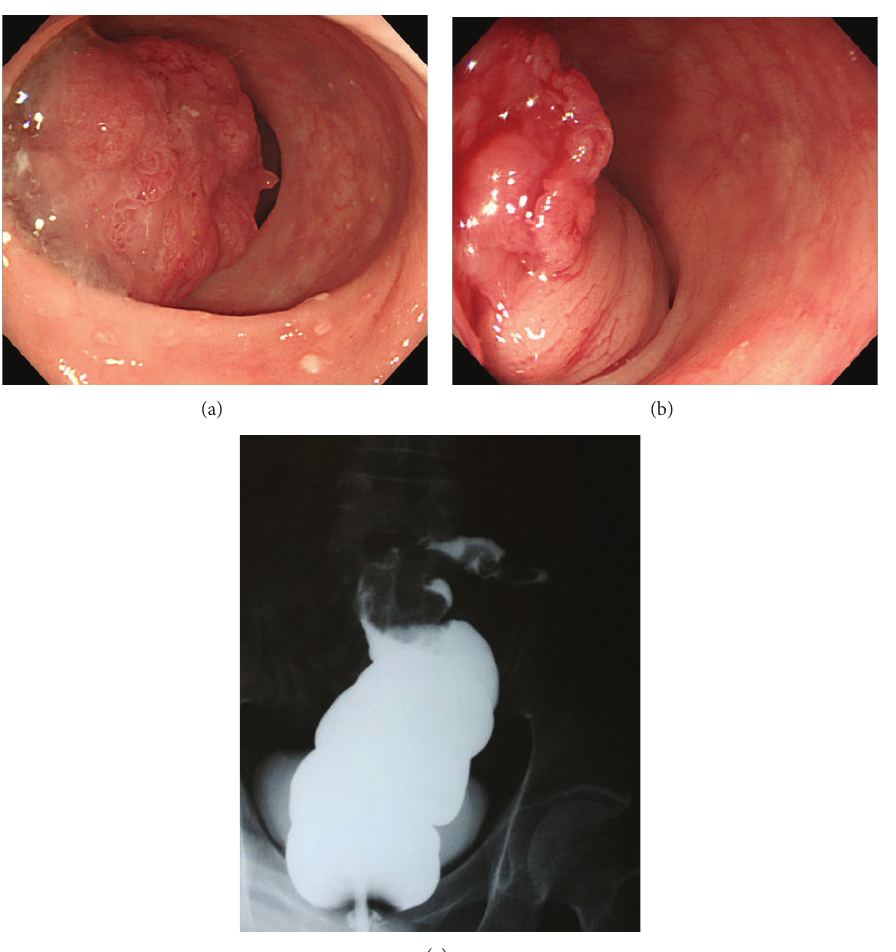
Figure 2: Sigmoidoscopy revealed a tumor occupying the lumen 15cm from anal verge (a). The bowel mucosa proximal mobile tumor was observed although the camera could not traverse beyond the lesion (b). Gastrografin enema demonstrating the tumor in the rectosigmoid colon without the typical coiled-spring appearance or cup-shape filling defect